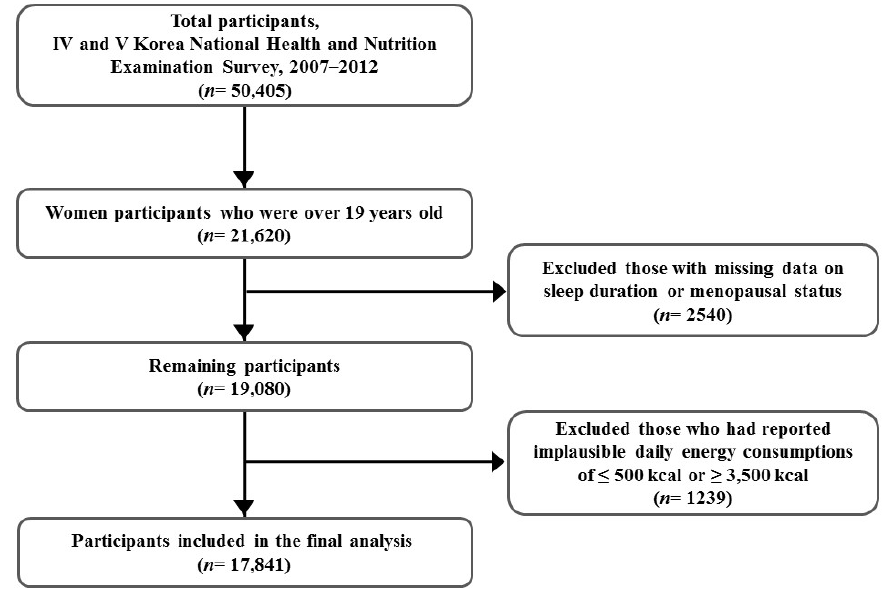
Figure 1. Framework of participants’ selection.